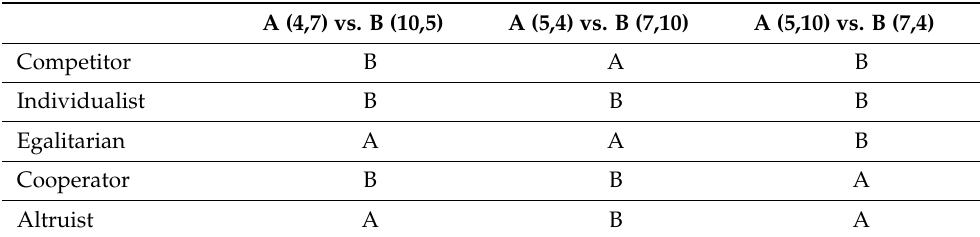
Table 2. Sample Items and Categorization Mode of Social Value